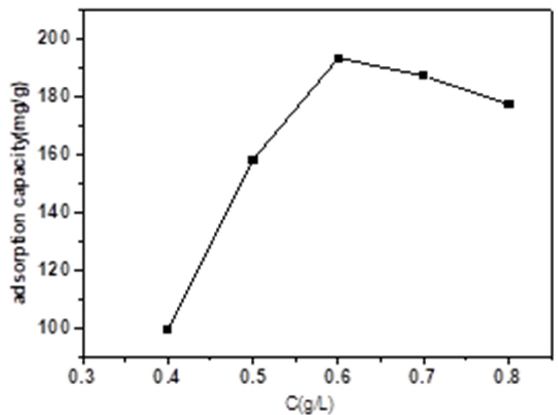
Figure 4. Effect of magnetic biochar dose (adsorption time: 18 h).